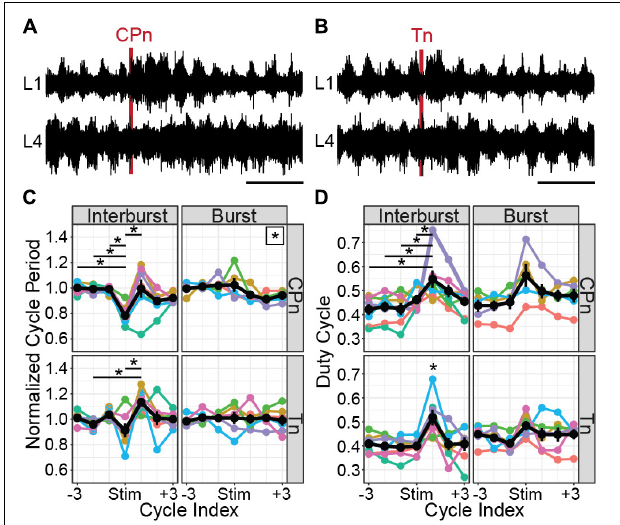
FIGURE 7 | CPn and Tn stimulation trains both induce flexor-biased resetting of drug-evoked fictive locomotion in cords from P1 to P3 mice. (A) Representative example of CPn stimulation (50 µ s, 20 Hz, 6 pulses) applied during the flexor interburst period of drug-induced locomotion. Top trace shows recording from L1 VR and bottom trace from L4 VR, corresponding to flexor and extensor motor output respectively. Following CPn stimulation (red line), there is truncation of the ongoing extensor burst and initiation of a new flexor burst. (B) Representative example of Tn stimulation applied during the flexor interburst period. Following Tn stimulation (red line), there is truncation of the ongoing extensor burst and initiation of a new flexor burst. In some cases, but not always, there is a short delay preceding the flexor burst initiation. (C) Normalized cycle period measured from L1 VR recordings before, during and after CPn and Tn stimulation delivered during either the flexor interburst period or burst. Cycles are defined as starting with the flexor burst. Colors correspond to different spinal cord preparations and the black line shows the mean and standard error. When stimulation was delivered during the interburst period, both CPn and Tn stimulation typically reduced the cycle period of the ongoing cycle by truncating the interburst period and increased the cycle period of the subsequent cycle containing the evoked flexor burst. Stars indicate significant pairwise comparison ( p < 0.05). A star in the upper right corner of the plot indicates significant omnibus test without significant post-hoc comparisons. (D) Duty cycle measured from L1 VR recordings before, during and after CPn and Tn stimulation during either the flexor interburst period or burst. Colors correspond to different spinal cord preparations and the black line shows the mean and standard error. Increase in duty cycle for the cycle following stimulation during the interburst period corresponds to an increased burst duration for the evoked flexor burst. A star directly above a point indicates significant pairwise comparisons ( p < 0.05) with every other